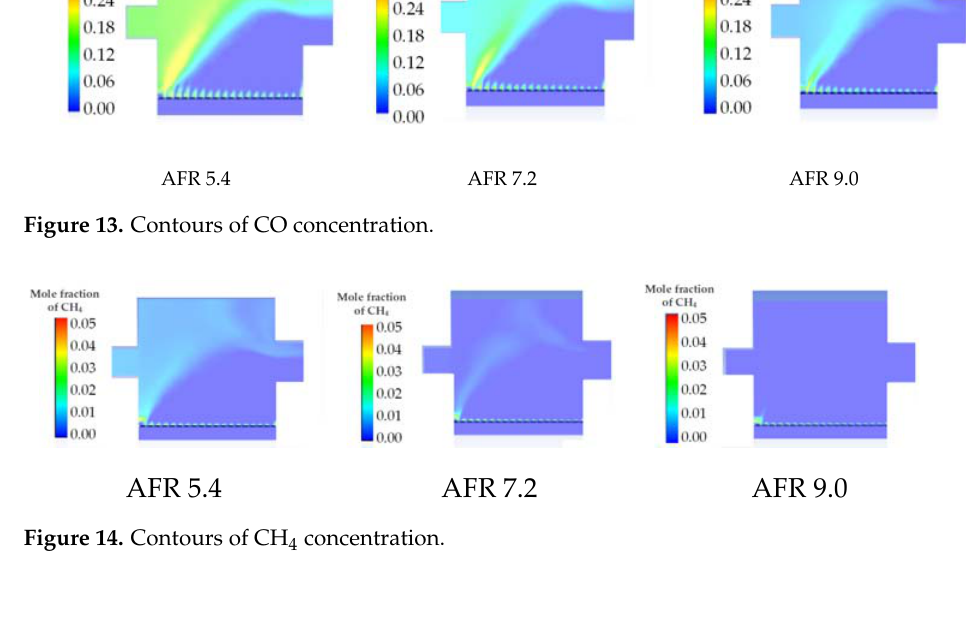
Figure 14. Contours of CH 4 concentration.